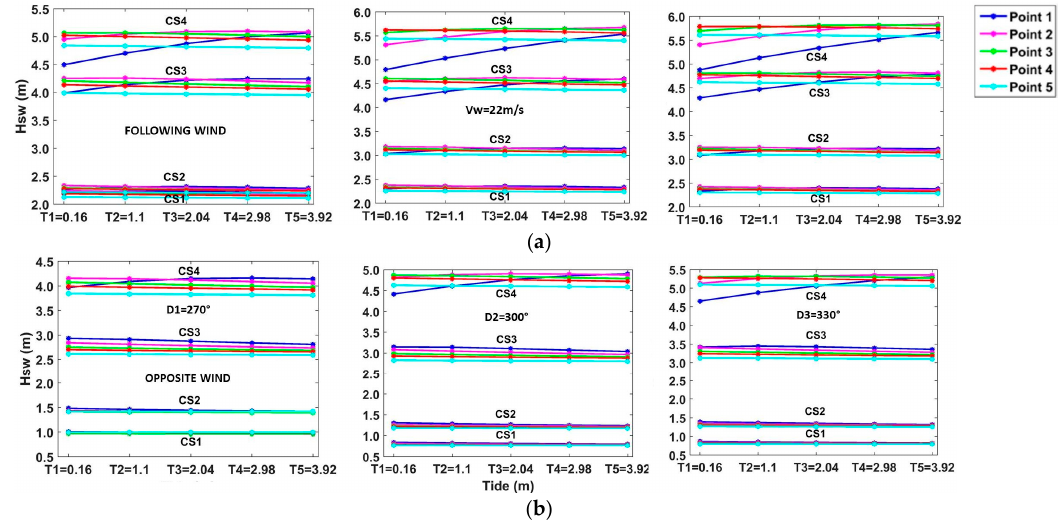
Figure 12. High wind conditions ( V w = 22 m/s): H sw variations along the reference points corresponding to the three different directions of the incoming waves (D1, D2, D3) and to the five tide conditions (T1, T2, T3, T4, and T5) for all the case studies considered (CS1, CS2, CS3, CS4): ( a ) following wind; and ( b ) opposite wind.